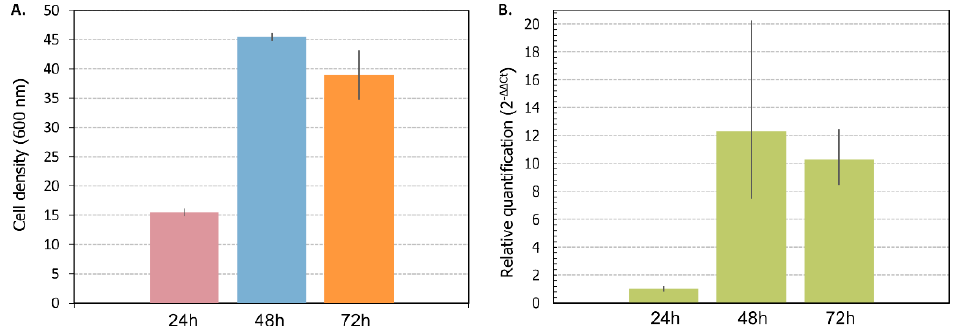
Figure 7. Relative quantification of the bacterial hemoglobin expressed in GLpm in batch cultivation under aerobiosis: ( A ) cell density at 24, 48, and 72 h of the cultivation time; ( B ) relative quantification of the bacterial hemoglobin ( VHb ) from RNAs extracted from cell pellets at 24, 48, and 72 h of the cultivation time. ACT1 gene was used as endogenous control, and timepoint 24 has the reference. Bars are SDs from two experiments.